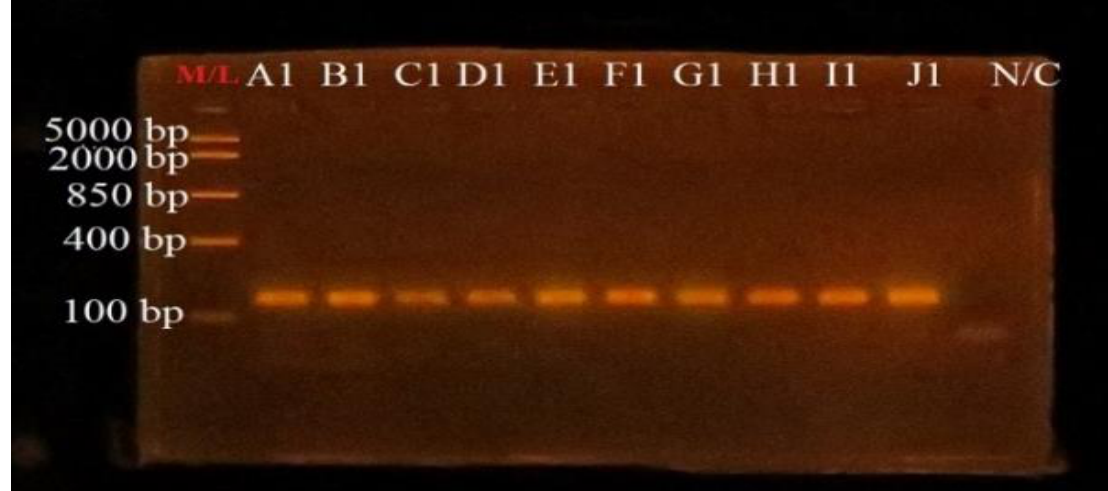
Figure 1. Agarose gel photo obtained from PCR products for identification of E. coli . M/L: Quick- Load ® Purple 100 bp DNA Ladder (New England Biolabs); A1 (Positive control, ATCC 25922); B1–J1 ( E. coli isolates, ~147 bp); N/C: Negative control.